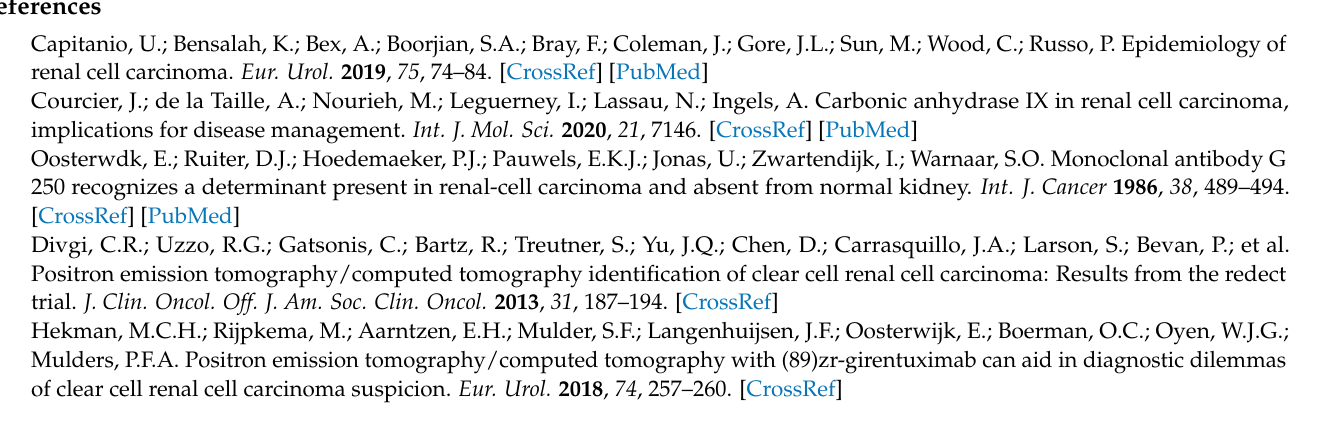
kidney. Table S1: The weight, the absolute uptake, and relative uptake over time of the spleen in mice treated with 50 kBq 225 Ac-hG250. Table S2: The weight, the absolute uptake, and relative uptake over time of the spleen in mice treated with 0.2 MBq 177